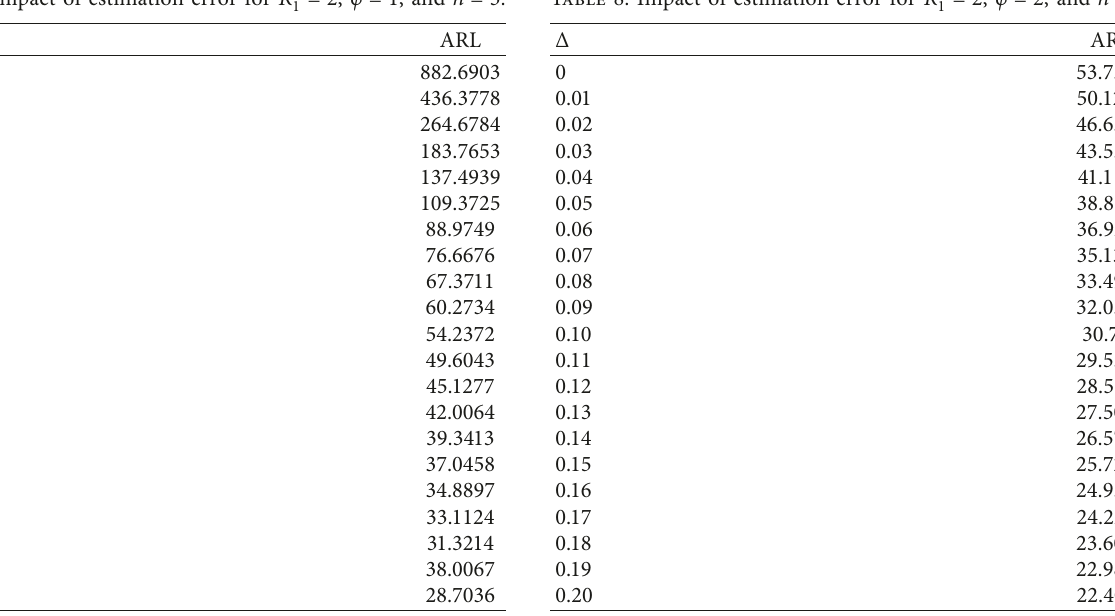
Table 6: Impact of estimation error for R